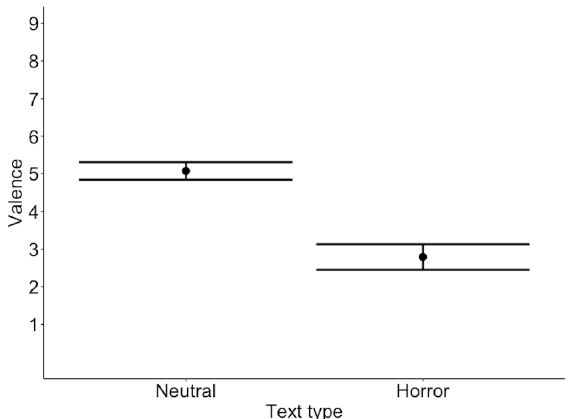
Figure 3. Model estimates for valence ratings. The scale on the y-axis is presented in discrete values corresponding to the SAM scale images (1 = extremely unpleasant, 9 = extremely pleasant) for the sake of clarity. Error bars represent 95% confidence intervals.